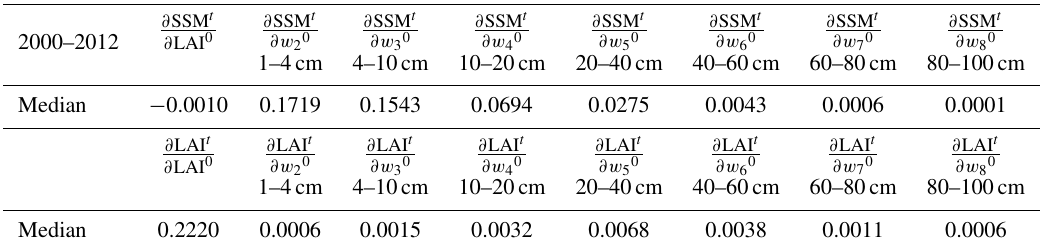
Figure 3. Top row, yearly averaged correlations between satellite-derived surface soil moisture from the Climate Change Initiative project from ESA and the second layer of soil of SURFEX–CTRIP ( w 2 : 1–4cm depth) for (a) 2000, (b) 2006 and (c) 2012. (d–f) Yearly averaged correlation between the GEOV1 leaf area index from the Copernicus Global Land Service project and SURFEX–CTRIP for 2000, 2006 and 2012, respectively. (g–i) same as (d–f) for RMSD. Table 2. Median Jacobian values for the eight control variables considered in this study over the whole spatial domain for